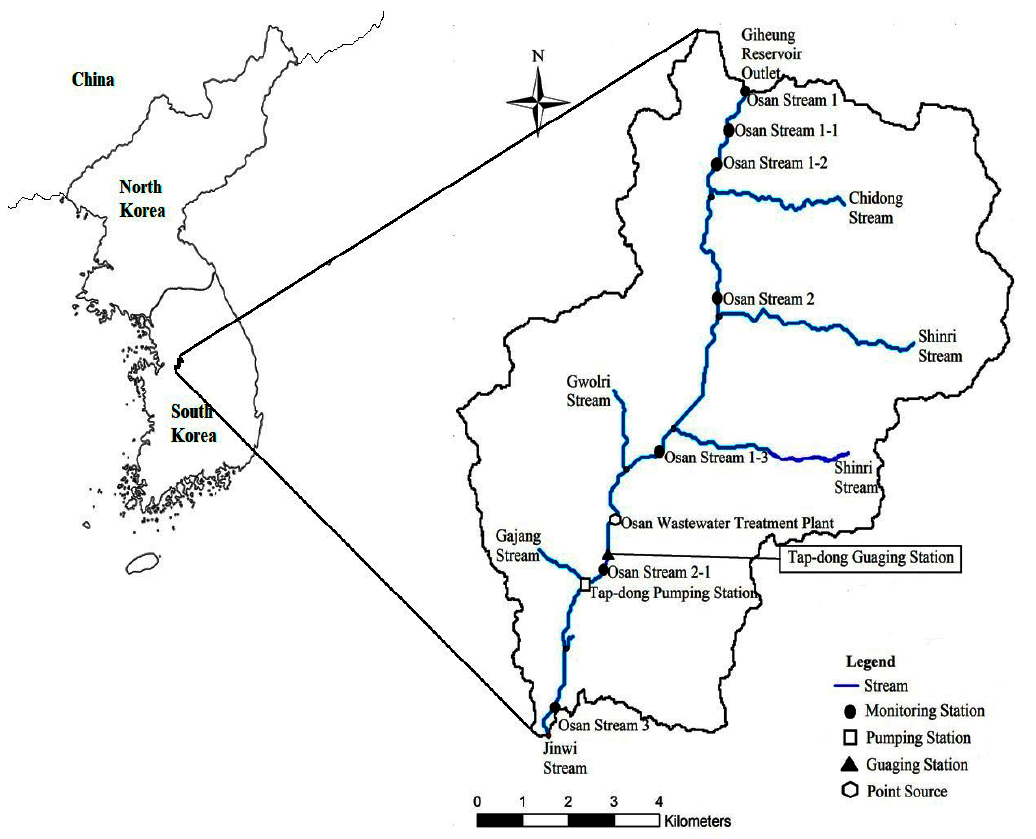
Figure 1. Location of Osan watershed.